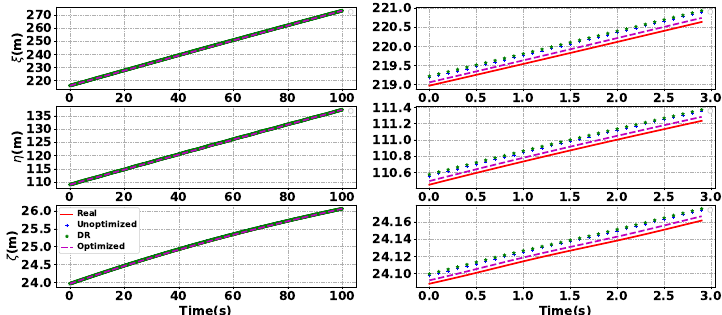
Figure 10. Identification result of AUV position.